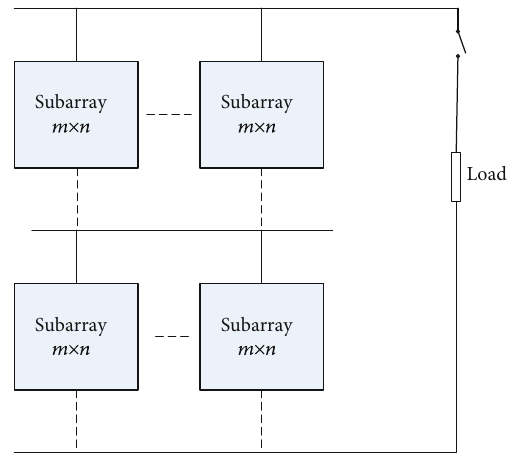
Figure 6: Connection of subarrays after dynamic recon fi guration.